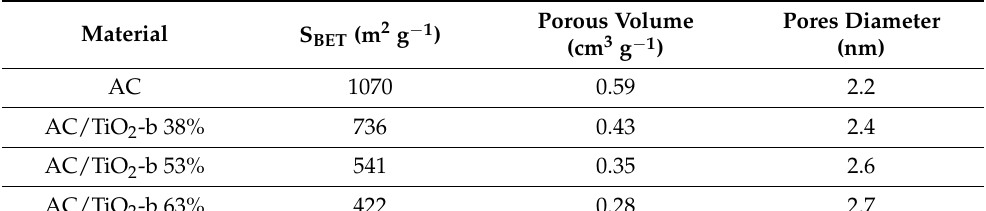
Table 2. Textural properties of AC and AC/TiO 2 composites, specific surface area (S BET ), porous volume, and pore diameter.